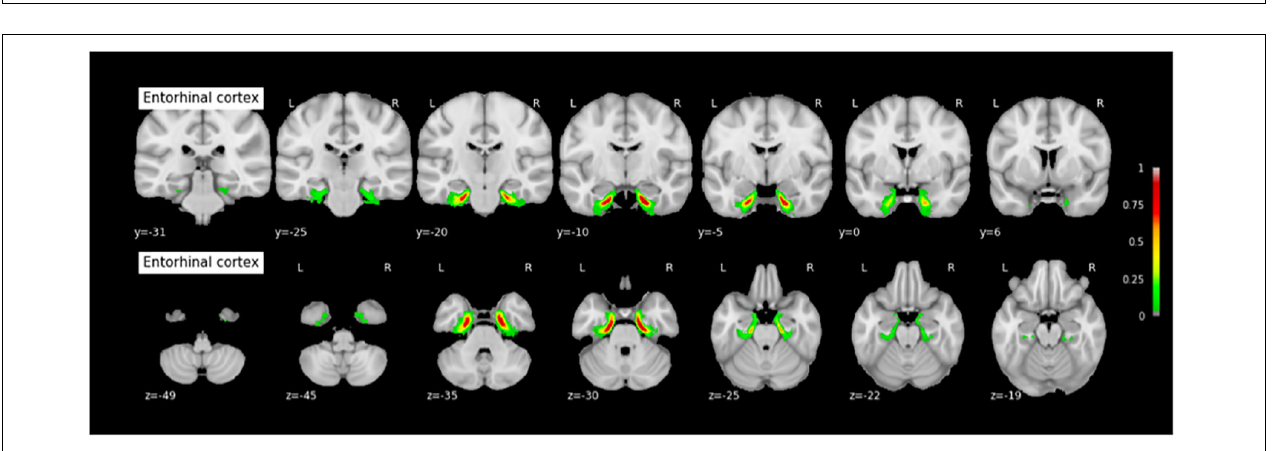
FIGURE 7 | Probabilistic map of the temporopolar cortex (TPC). The maps are normalized into the MNI stereotaxic space. Coordinates are indicated on each slice.